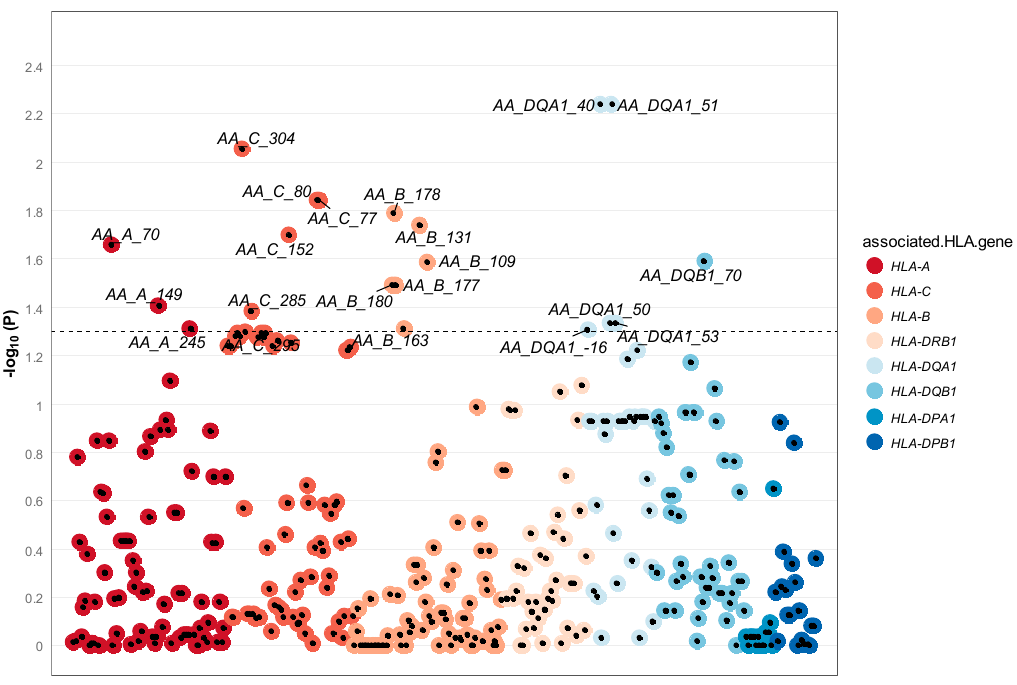
Figure 4. Manhattan two-sided p -value for each amino acid polymorphism tested. HLA Amino acid polymorphisms are displayed along the X -axis, with minus log ten two-sided p -value displayed on the Y -axis. Each data point in the plot signifies an amino acid residue. The color of the data point indicates the different HLA genes.